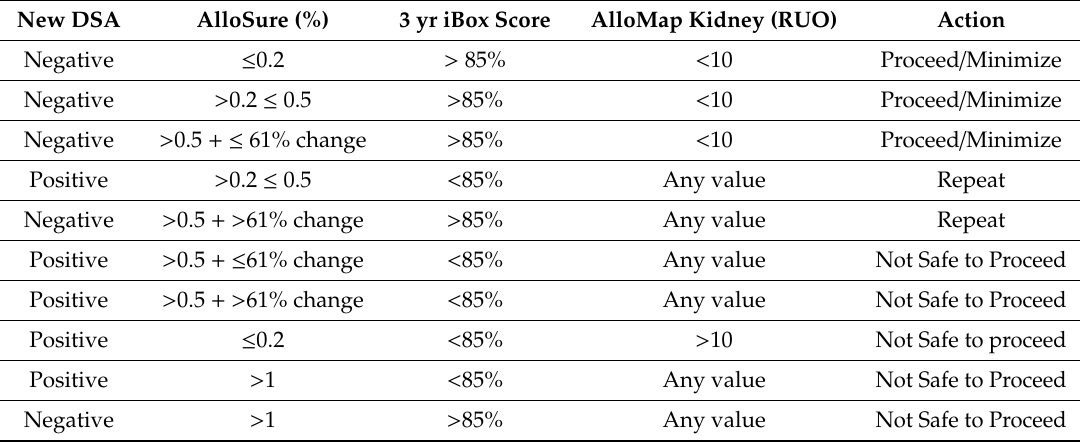
Table 5. Immunosuppression minimization / optimization will be determined by KidneyCare Results and DSA as to when it is safe to